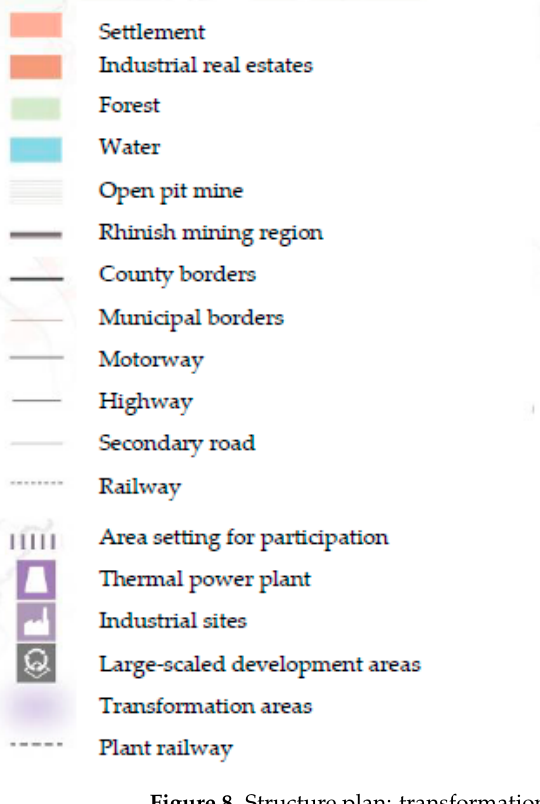
Figure 8. Structure plan: transformation map. Source: own Figure.